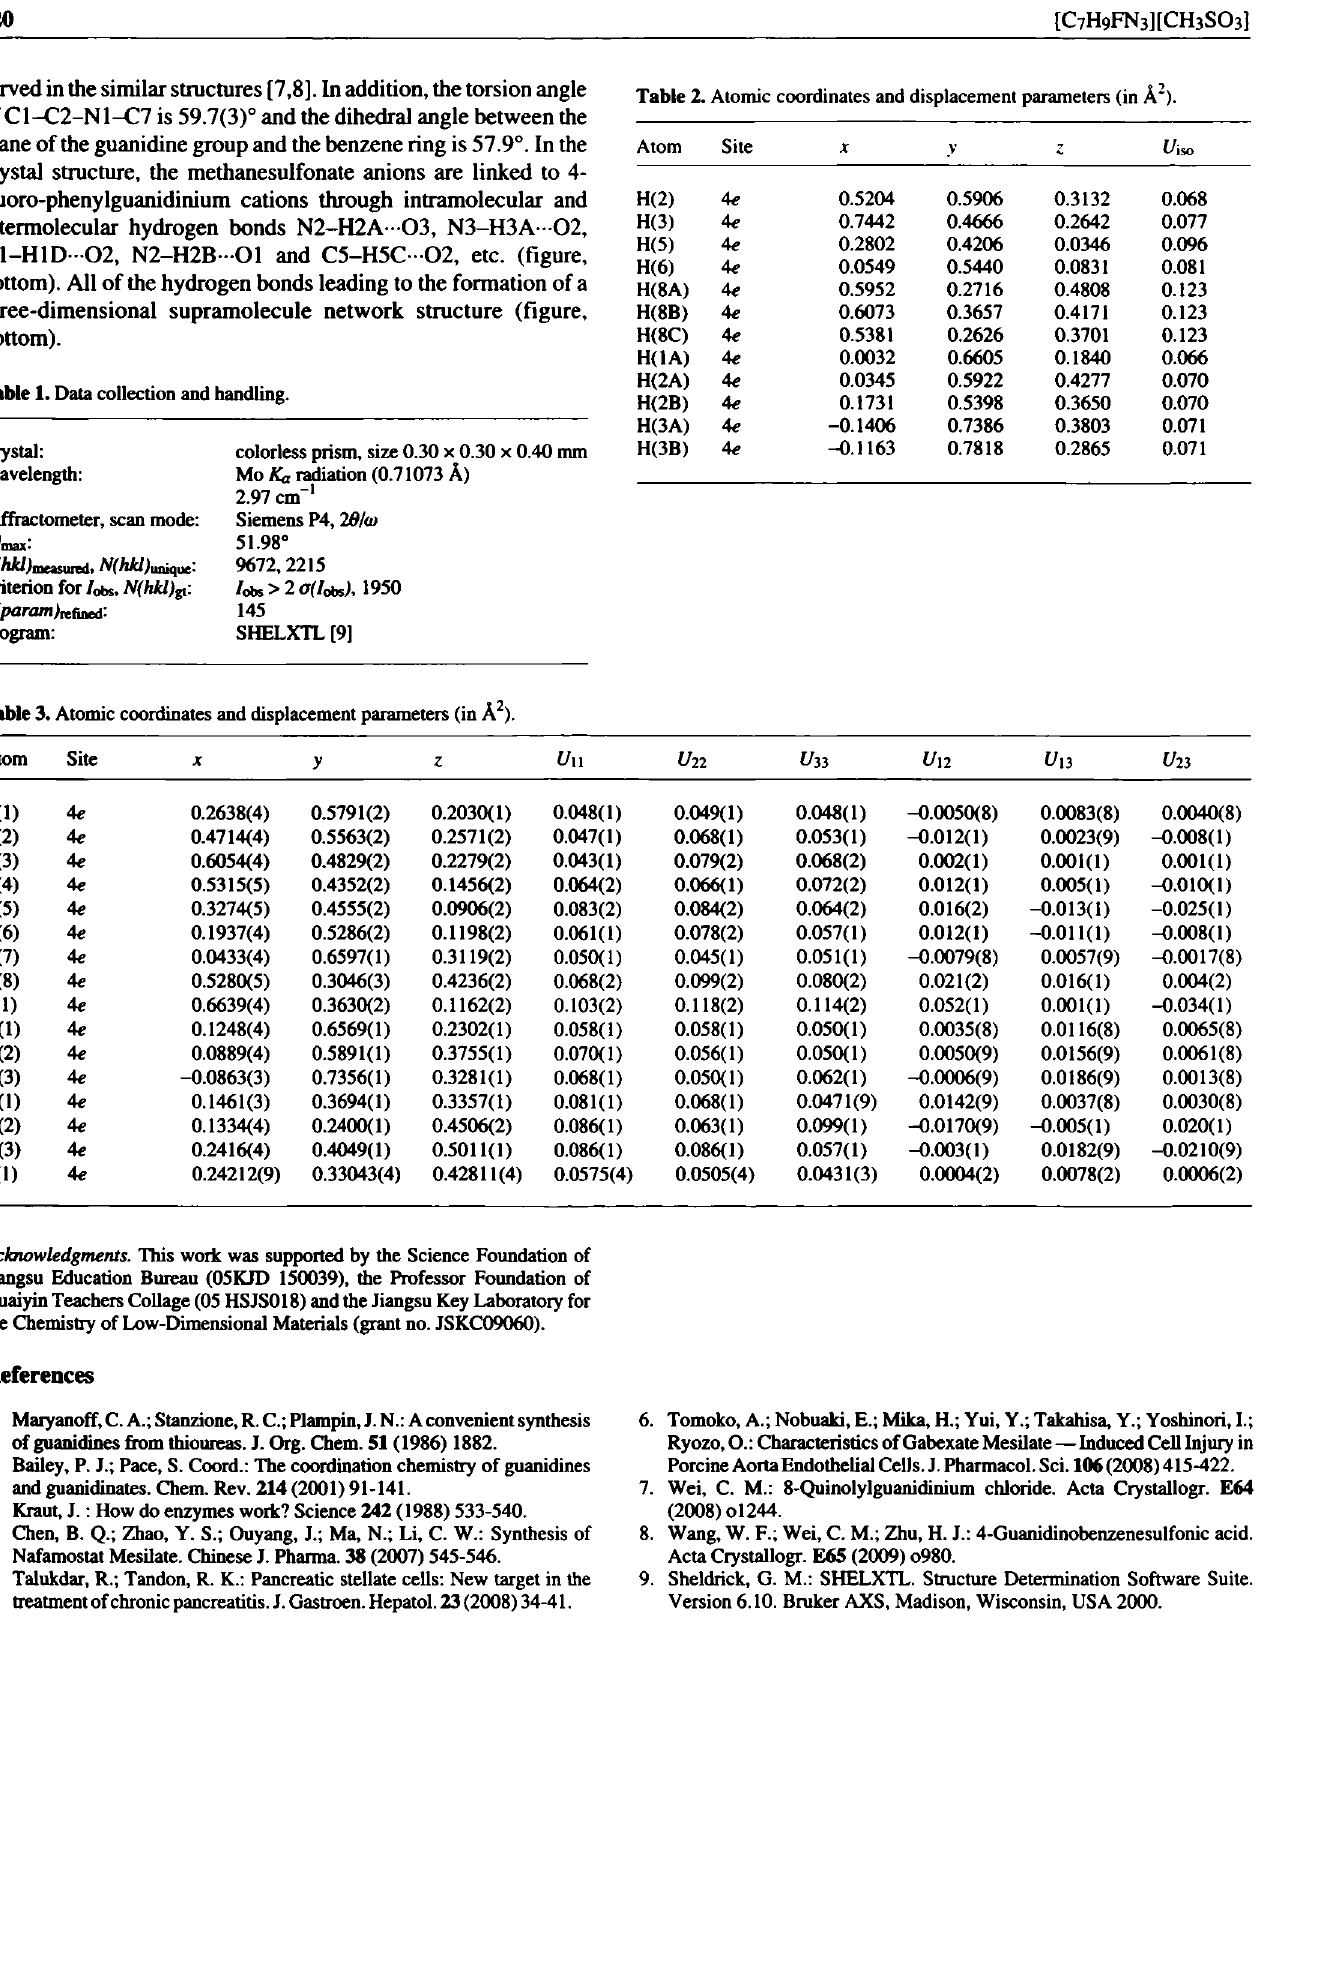
Table 2. Atomic coordinates and displacement parameters (in Â 2 ).